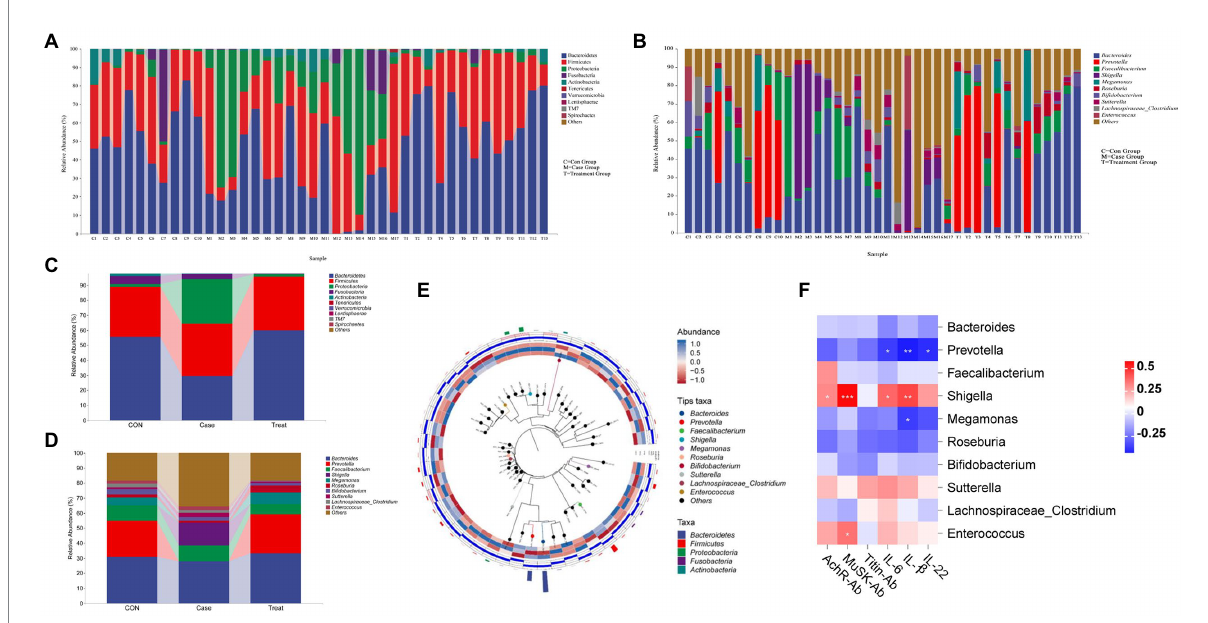
FIGURE 2 Species composition and association analysis. (A,C) Composition and distribution of intestinal microbiota at phylum level in Case group, Treatment group and CON group. (B,D) Composition and distribution of intestinal microbiota at genus level in Case group, Treatment group and CON group.